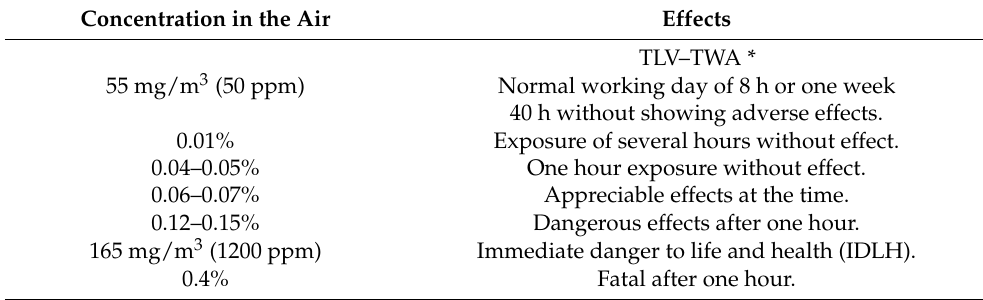
Table 1. Effects of CO on people according to exposure